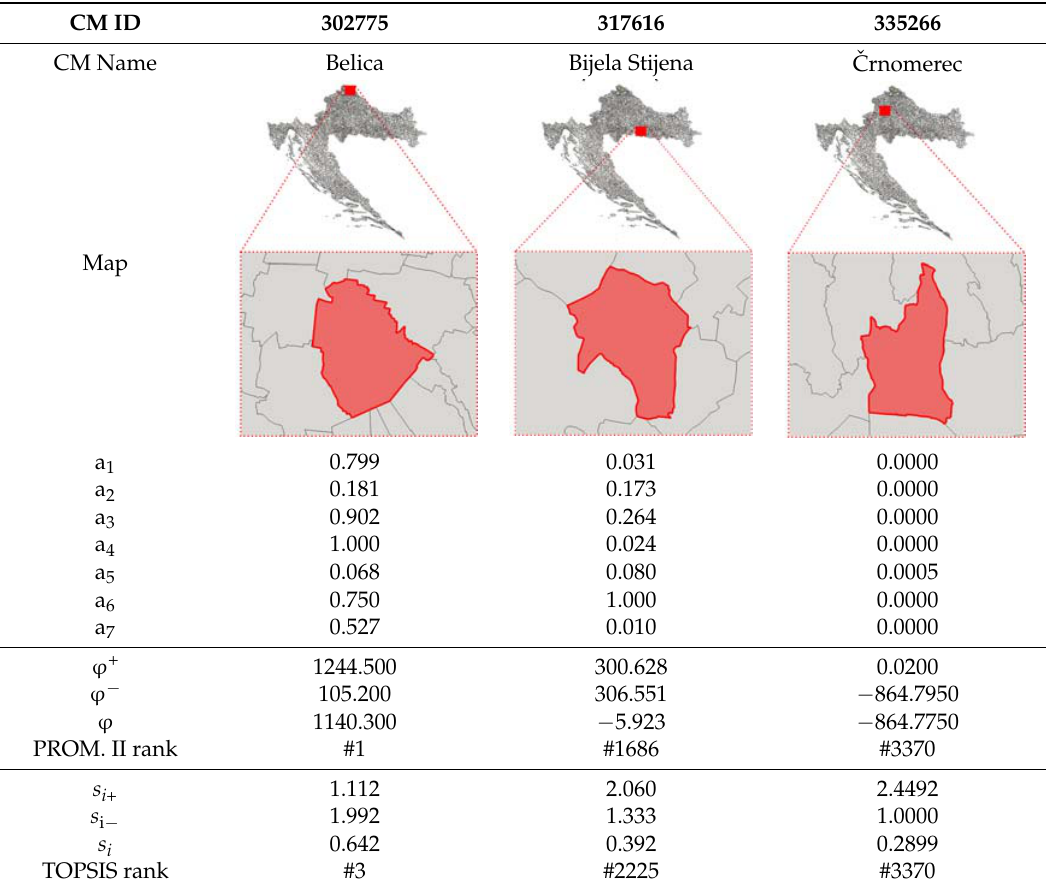
Figure 5. Scatterplot of CM PROMETHEE scores. Table 3. Examples of TOPSIS and PROMETHEE ranking.